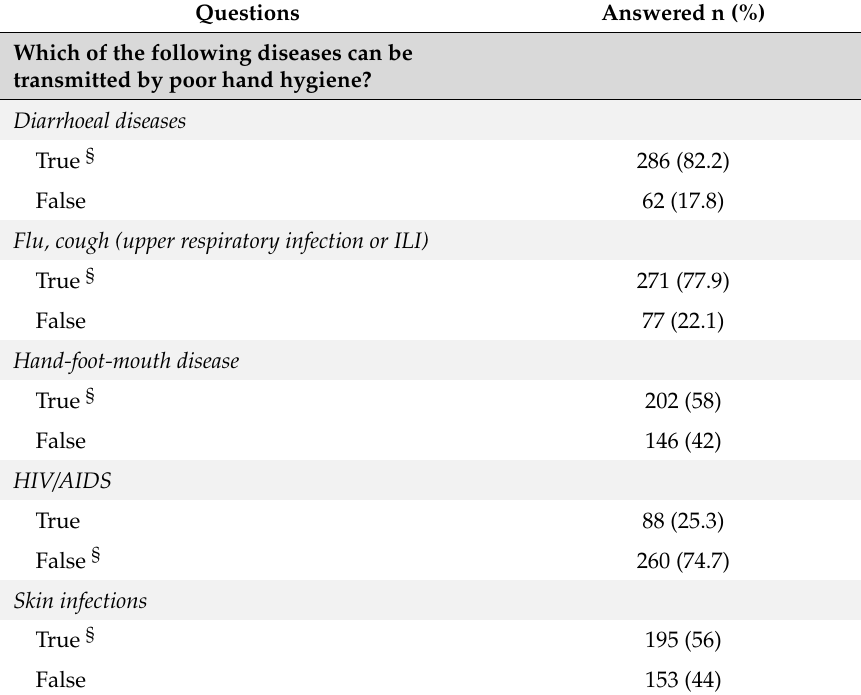
Table 3. Hand hygiene knowledge level among respondents (N =